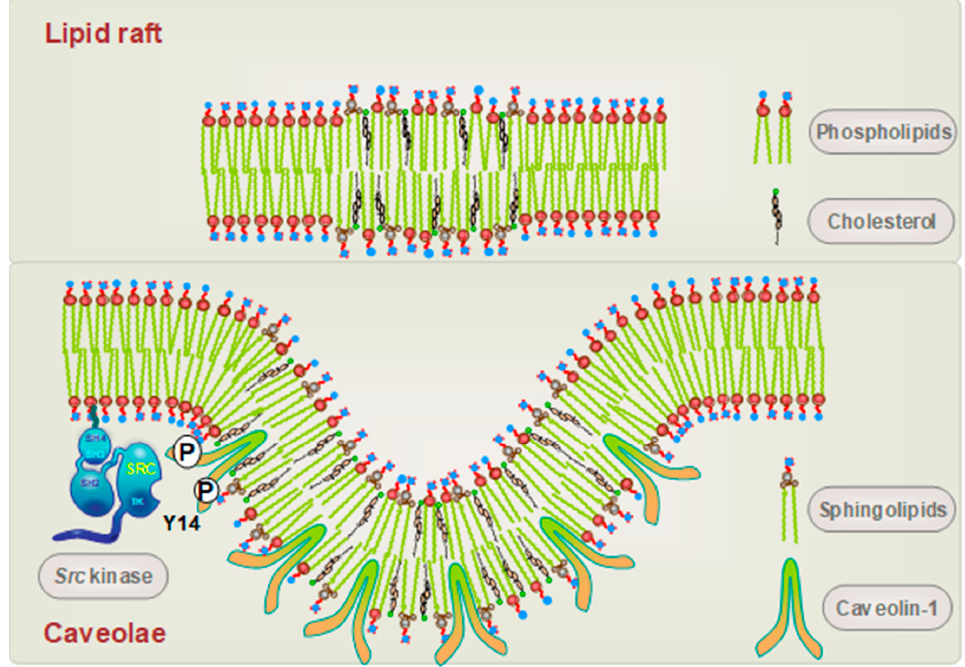
Figure 1. Comparative structures of lipid rafts and caveolae, two major cholesterol-rich membrane microdomains. Caveolin-1 is a key membrane protein necessary for the formation of cholesterol- and sphingolipid-enriched caveolae. Src family kinases phosphorylate caveolin-1 at Y14 promoting interactions with a subgroup of signaling e ff ectors including the EGFR and FAK, as seen in Figure